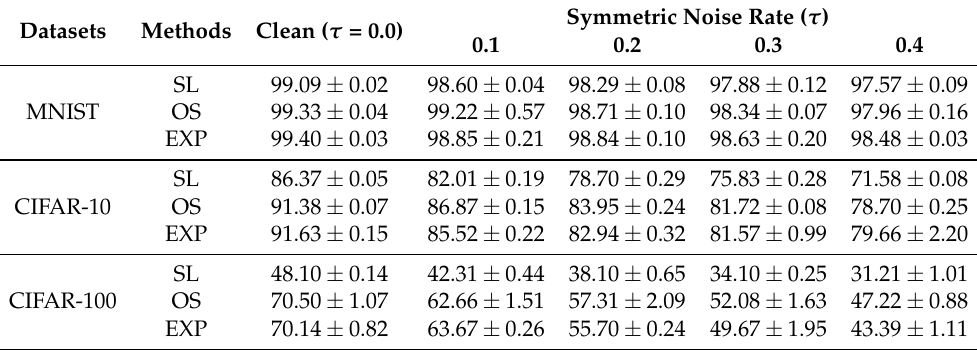
Table 3. Test accuracy (%) of different methods on benchmark datasets with clean or symmetric label [ 0.1,0.4 ] ). The results (mean noise ( τ std) are reported over three random runs. SL refers to a ∈ ± training schedule with a small learning rate that remains constant throughout the training process. OS (one-step) denotes a training schedule where the learning rate starts at a high value and then drops to a smaller value after a specified number of training steps. Exp refers to a training schedule where the learning rate decreases exponentially as the training